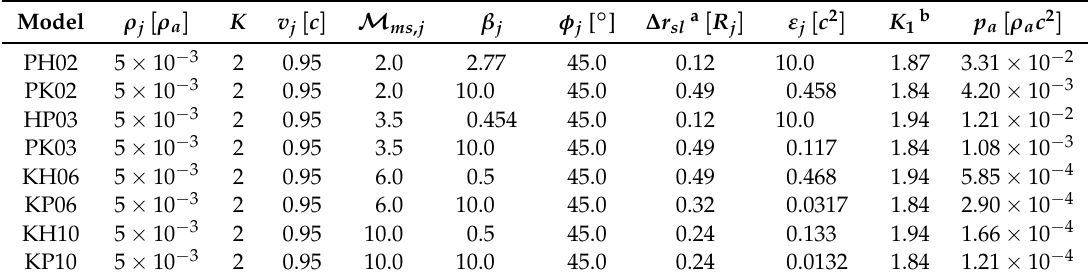
Table 1. Parameters defining the overpressured jet models.